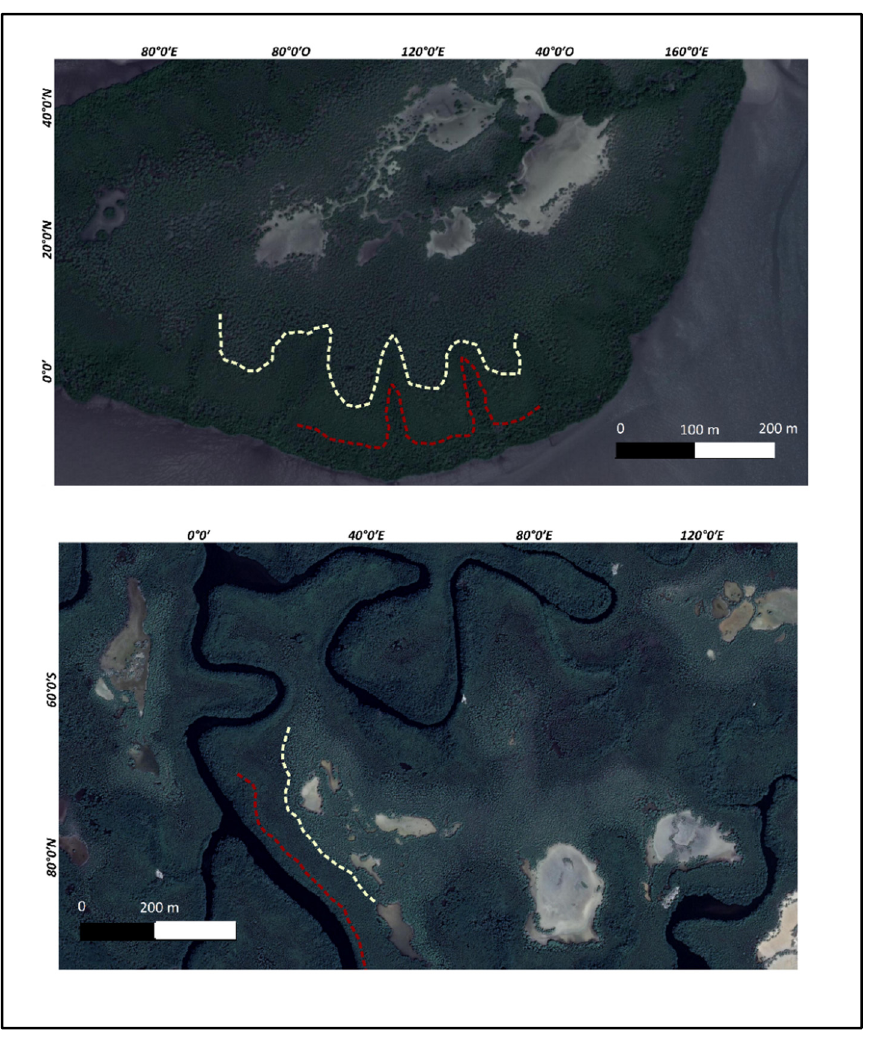
Figure 3. Very-high-resolution Google Earth (GE) image for the photointerpretation of the three vegetation formations. The top is a zonation in the Saloum, and the bottom is in Casamance. The red line symbolizes the interface between dense high mangrove and dense low mangrove. The white line symbolizes the interface between the low and dense mangrove and the low and open mangrove.